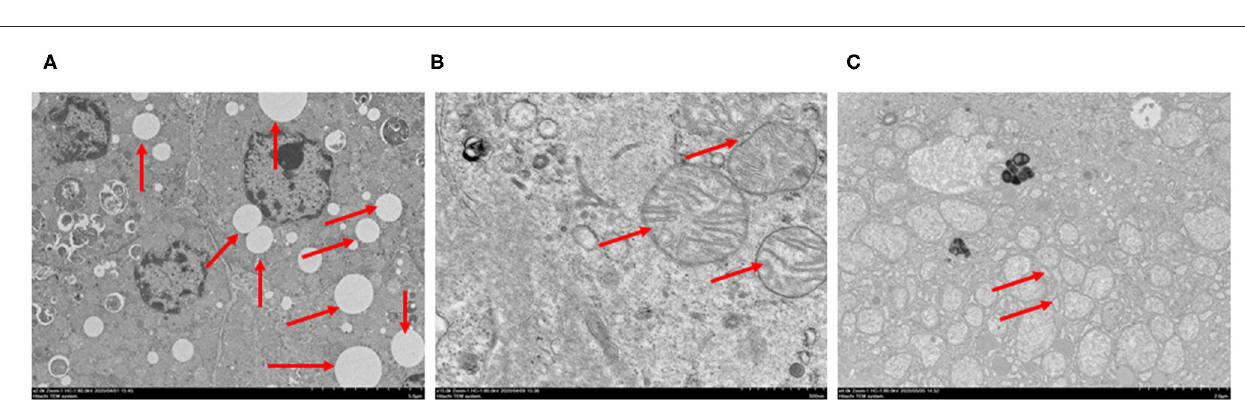
FIGURE 2 | Spectrum of ultrastructural abnormalities of liver tissues from postmortem of patients with COVID-19. (A) vacuolar degenerations in hepatocytes (arrows), (B) edematous of mitochondria and the disruption of cristae (arrows), (C) expansion of endoplasmic reticulum (arrows). Bars = 5 µ m (A) , 500nm (B) , 2 µ m (C)